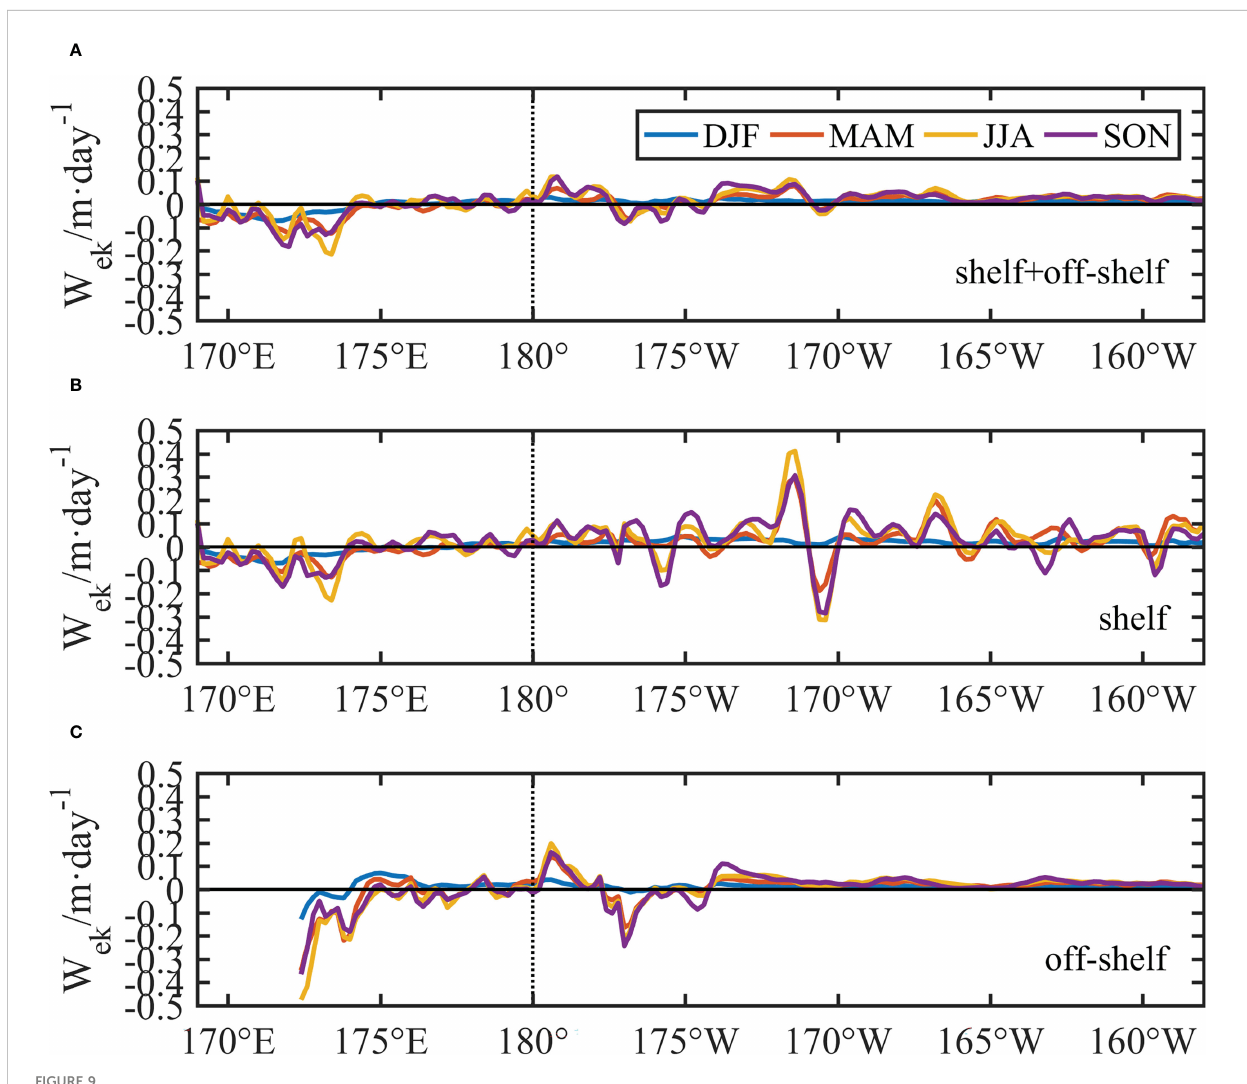
FIGURE 9 (A – C) Averaged seasonal Ekman pumping velocity W ek (positive: upward) in the entire area between 71.5°S – 77°S in the latitude and 169°E – 158°W in the longitude, the shelf area, and the off-shelf area, respectively. The shelf and off-shelf areas are divided by the 700-m isobath, and the black dash line represents the 180°